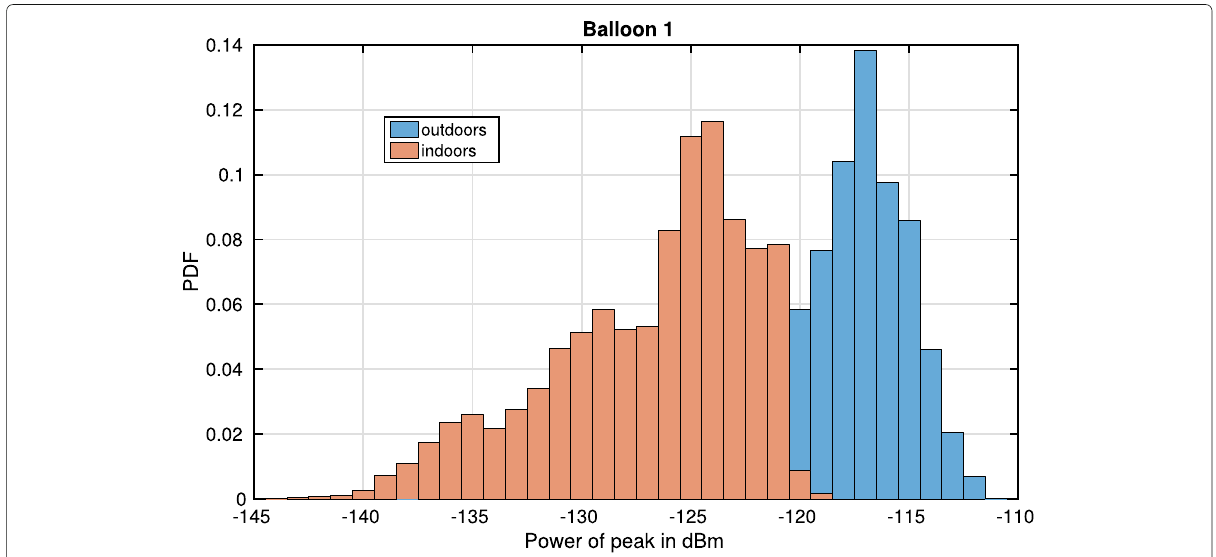
Fig. 12 Signal power distribution from Loon HAP 1 (~40 km away), indoor vs outdoor